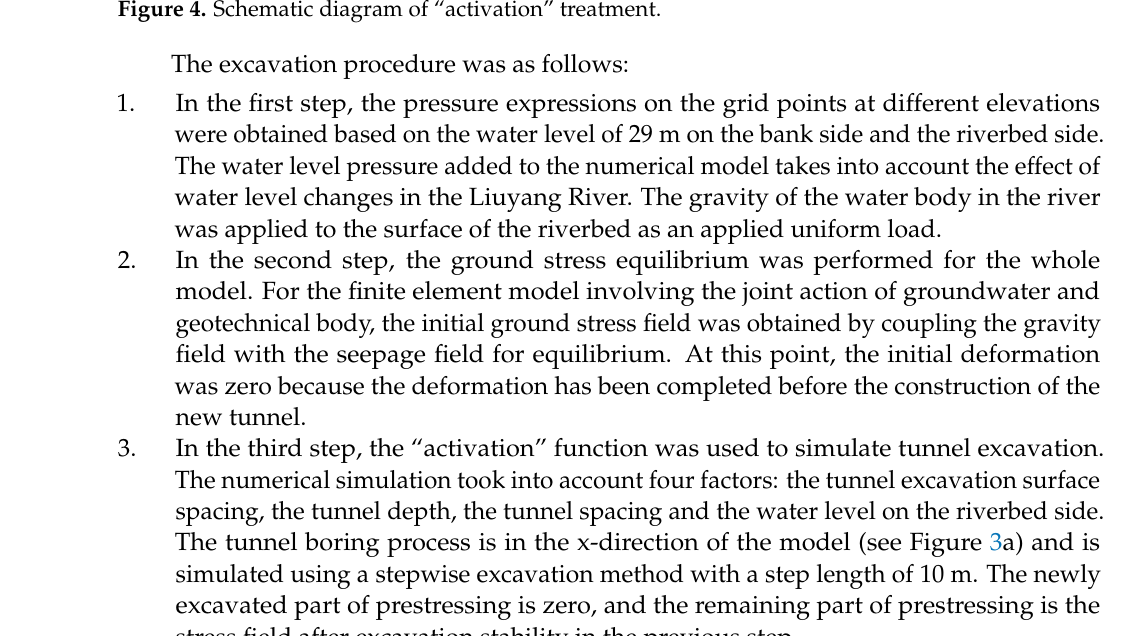
Figure 4. Schematic diagram of “activation” treatment.